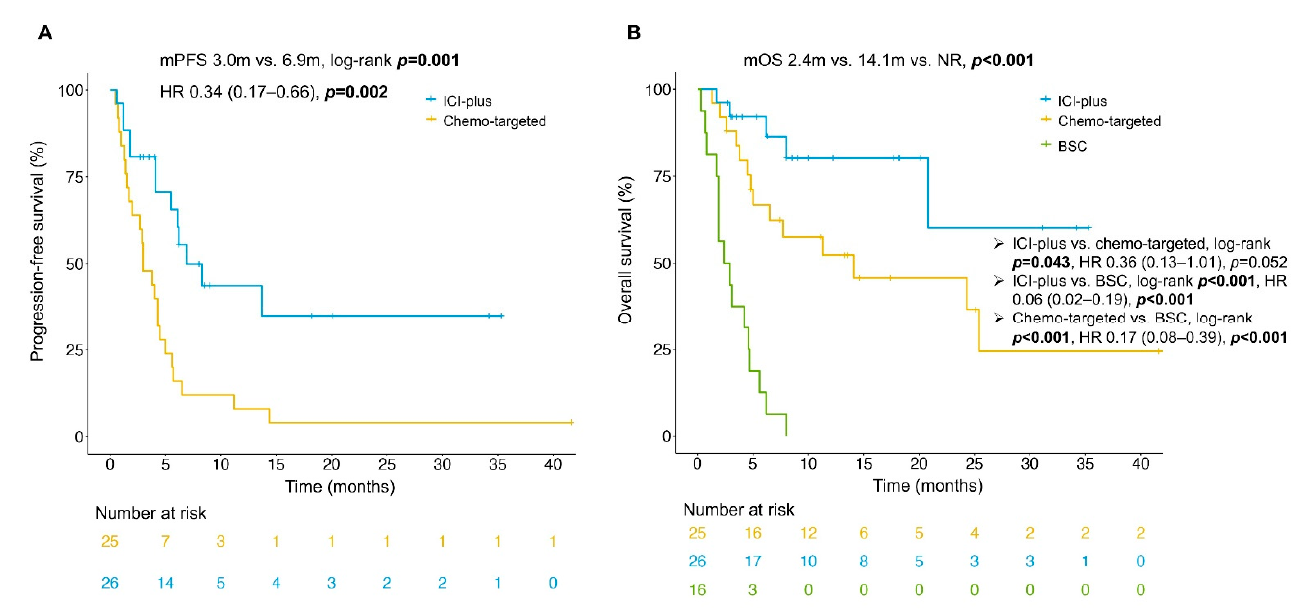
Figure 2. Best response and duration of each line of therapy since the application of anti-PD1/PD- L1 monotherapy in the ICI-plus group ( A ) and chemo-targeted group ( B ). For patients who lacked detailed information about treatment before the date of death or censoring, the graph bar was pre- sented by blank. Abbreviations: ICI-plus: anti-PD1/PD-L1 plus other therapy; chemo-targeted: chemotherapy with or without targeted therapy; BSC: best supportive care; NA = not available; PD = progressive disease; PR = partial response; SD = stable disease.